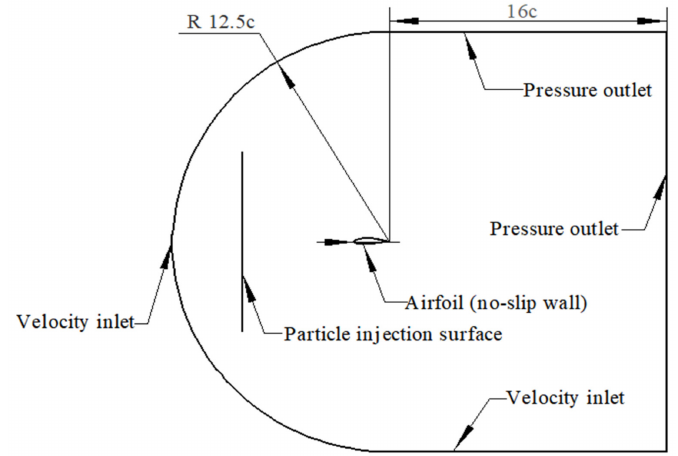
Figure 5. Calculation domain and boundary conditions.